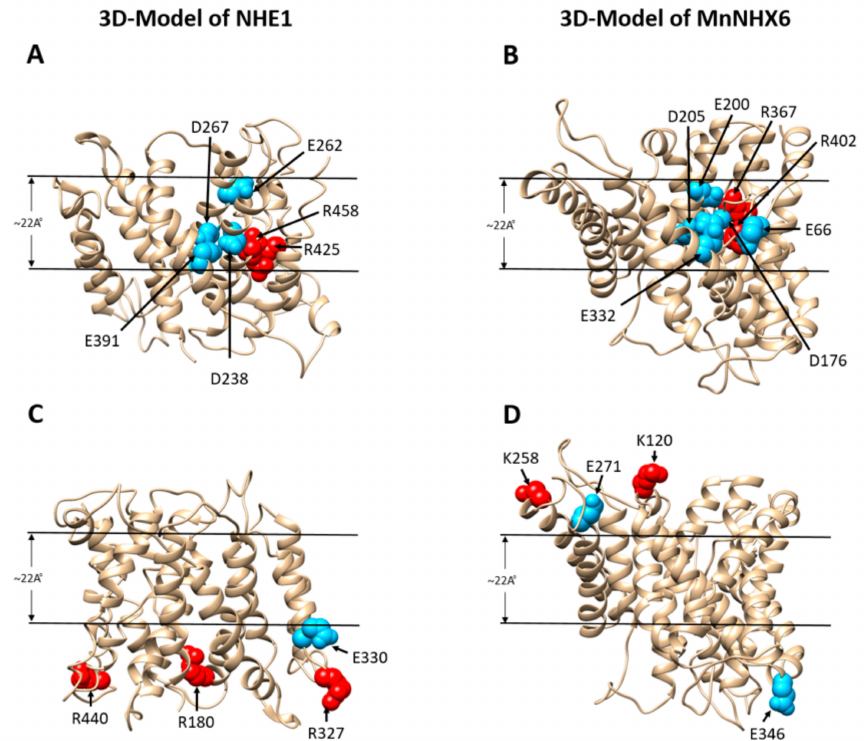
Figure 5. The essentially titratable residues in MnNHX6 and NHE1. Ribbon representations of a side view of the NHE1 ( A , C ) model [18] and our MnNHX6 ( B , D ) model, which are displayed with the intracellular region in the upward direction. The essentially titratable residues in the TM4–11 assembly region of NHE1 and the TM5–12 assembly region of MnNHX6 are shown in panels ( A ) and ( B ), respectively. The essentially titratable residues in the extramembrane loops of NHE1 and MnNHX6 are shown in panels ( C , D ), respectively. In all the panels, the negatively and positively charged residues are shown as blue and red spheres,